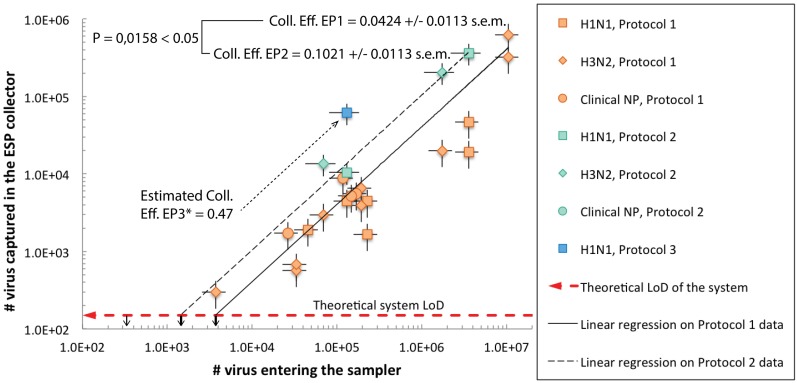
Measurements of the total amount of viruses detected with qPCR versus the total amount of viruses entering the ESP sampler.Linear regressions were performed using the least-square method on data groups obtained using EP1 and EP2. The qPCR LoD reported to the sampling volume is plotted with a horizontal dashed red arrow and enables calculating the theoretical system LoDs, indicated with black arrows. The collection efficiencies for EP1 and EP2 are significantly different with a probability P = 0.0158 < 0.05 and are indicated with the corresponding standard error. *For EP3, only a single measurement was successfully obtained. The corresponding collection efficiency can be estimated using Eq 1.